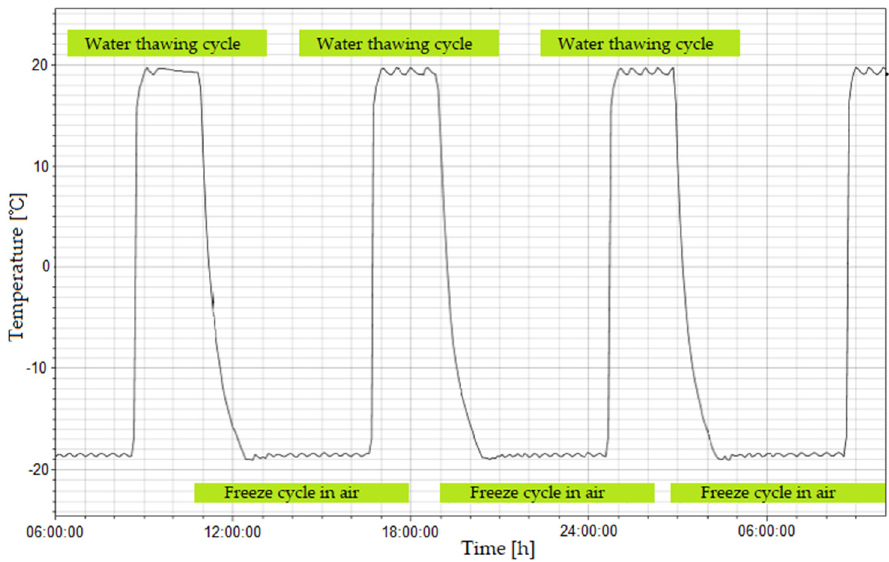
Figure 4. Cycles of freezing in air and thawing in water, according to [18,19].